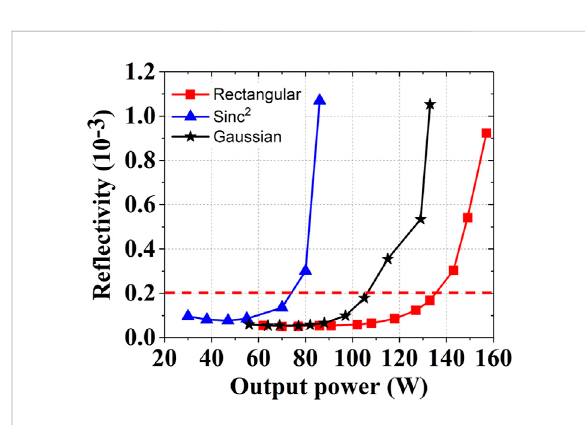
FIGURE 7 The re fl ectivity versus the output power of fi ber ampli fi ers with different